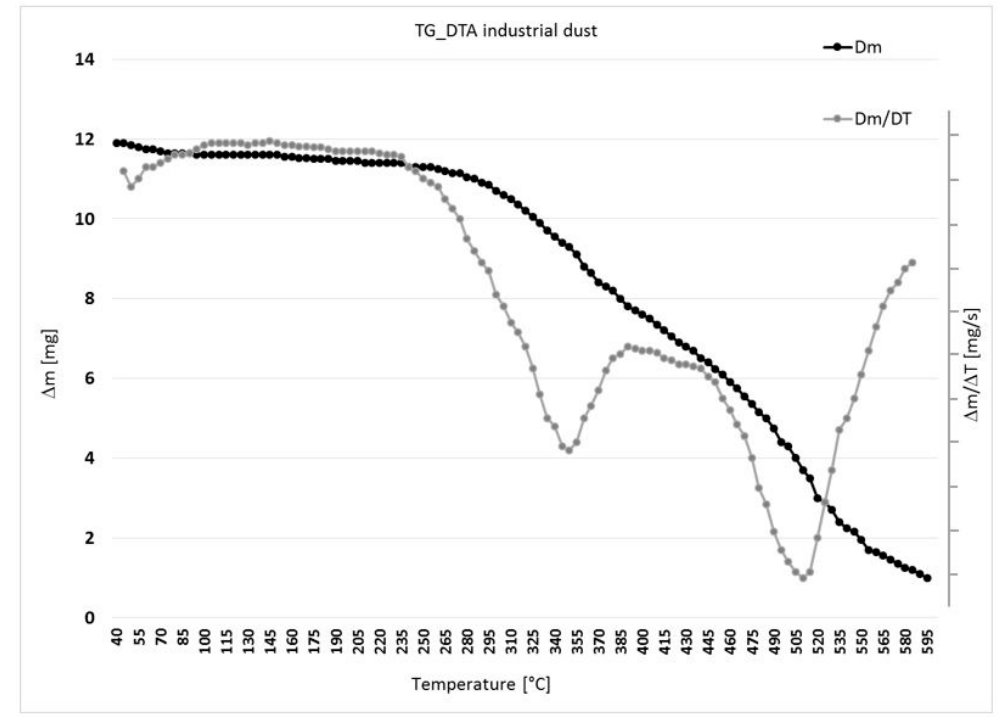
Figure 3. TG a DTA analysis of the industrial dust.